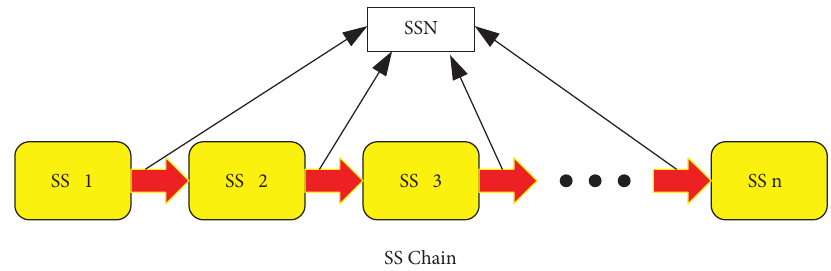
Figure 2: States chain and status